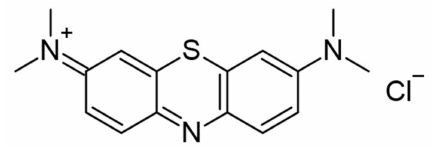
Figure 10. Chemical structure of methylene